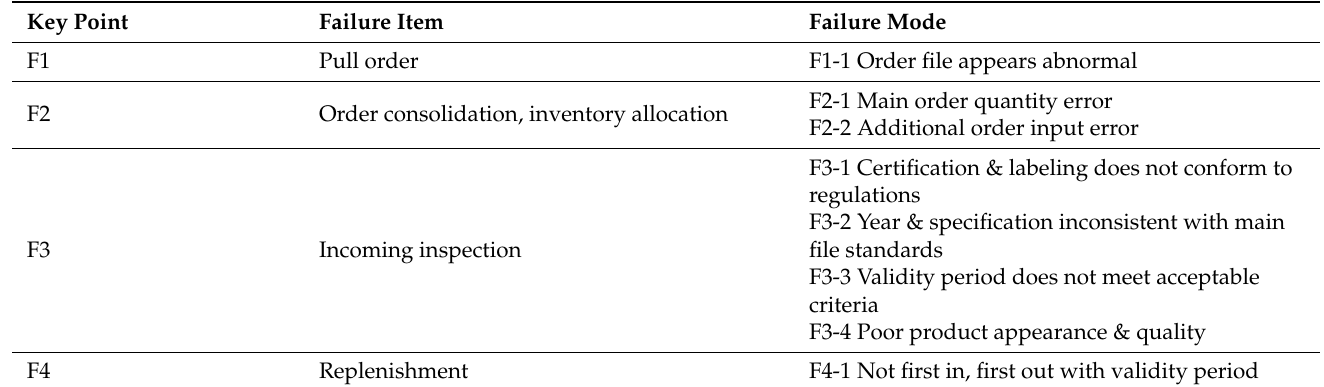
Table 1. Operation failure mode analysis of logistics